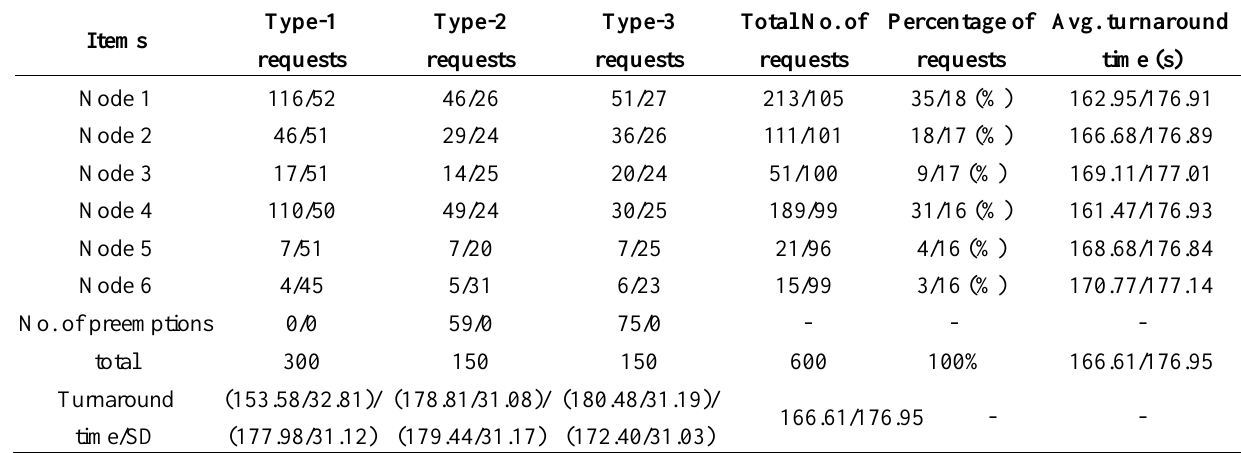
Table 15. The numbers of allocated requests and their turnaround times when 300 type-1, 150 type-2, and 150 type-3 requests were submitted, and the SPA-WP/Random were employed.